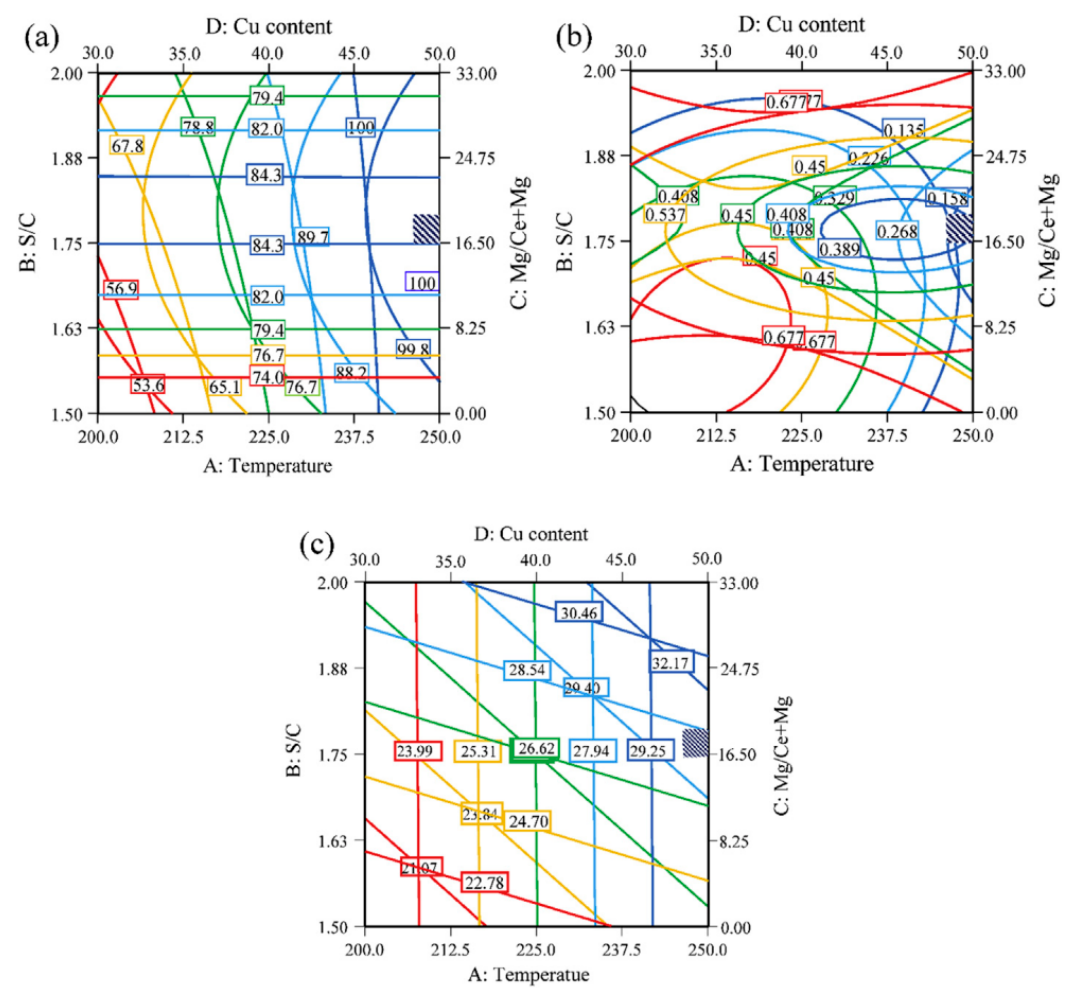
Figure 12. Contour plots for the optimal conditions for the methanol conversion ( a ); CO selectivity ( b ); H 2 yield ( c ) [180].